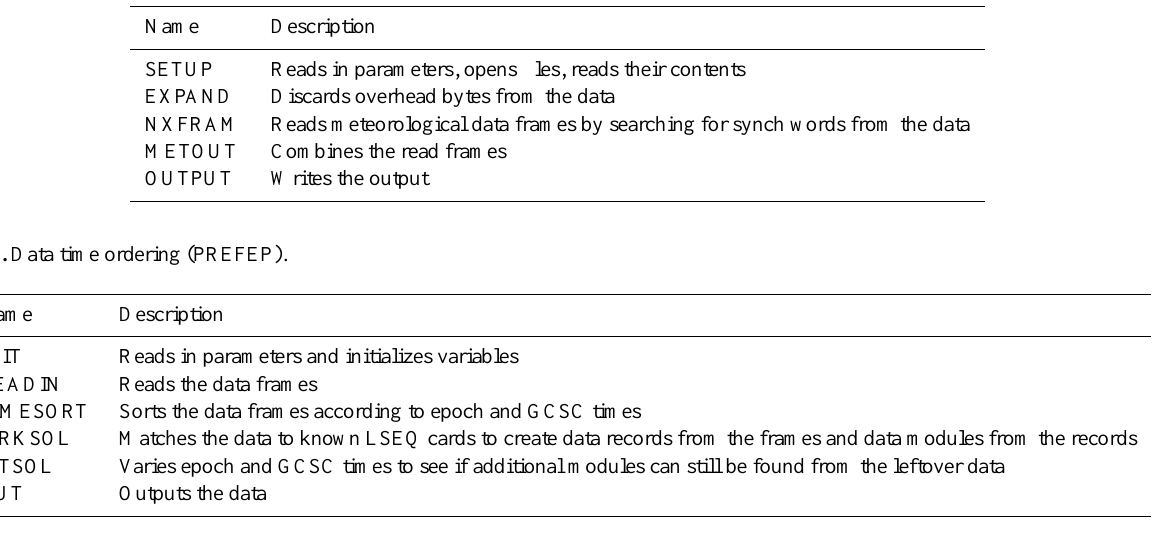
Table 1. Meteorology frame extraction (DECSET).